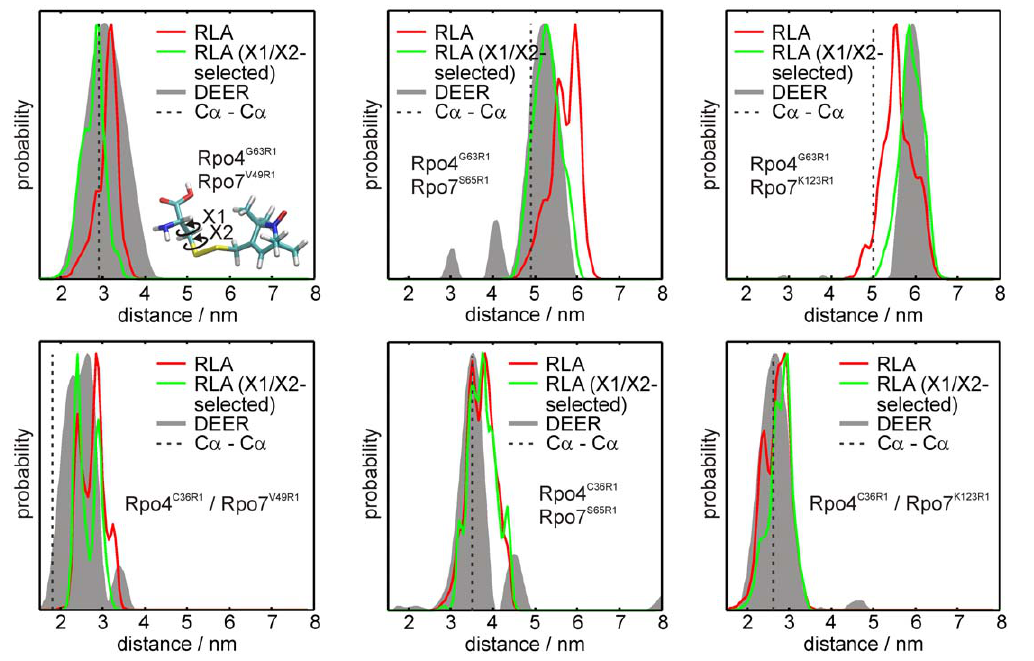
Figure 7. Rotamer library analysis for the spin label pairs in Rpo4/Rpo7. Distance distributions resulting from the DEER experiments are shown in gray. Simulated distance distributions were obtained from the RLA (red) and from a rotamer selection according to the crystal structures of spin labeled T4 lysozyme (green) [37]. The inset in the upper left panel shows the two dihedral angles X1 and X2 discussed in the text (see also Figure